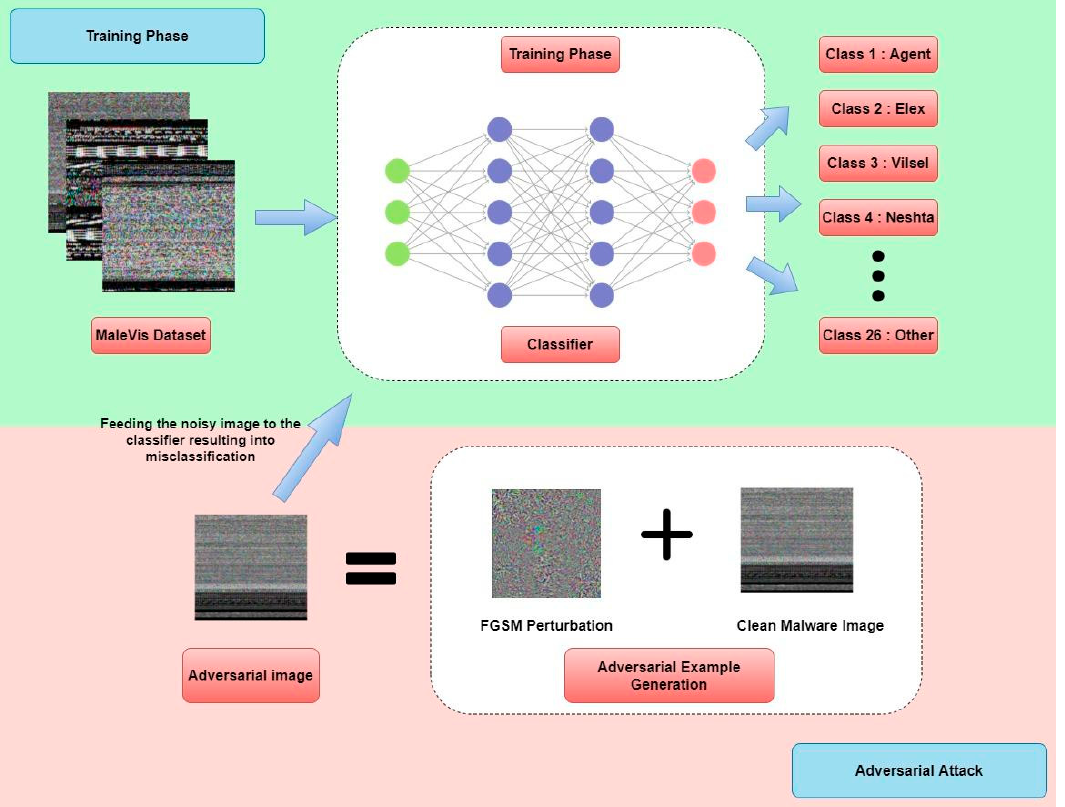
Figure 10. Schematic representation of adversarial Attack performed.